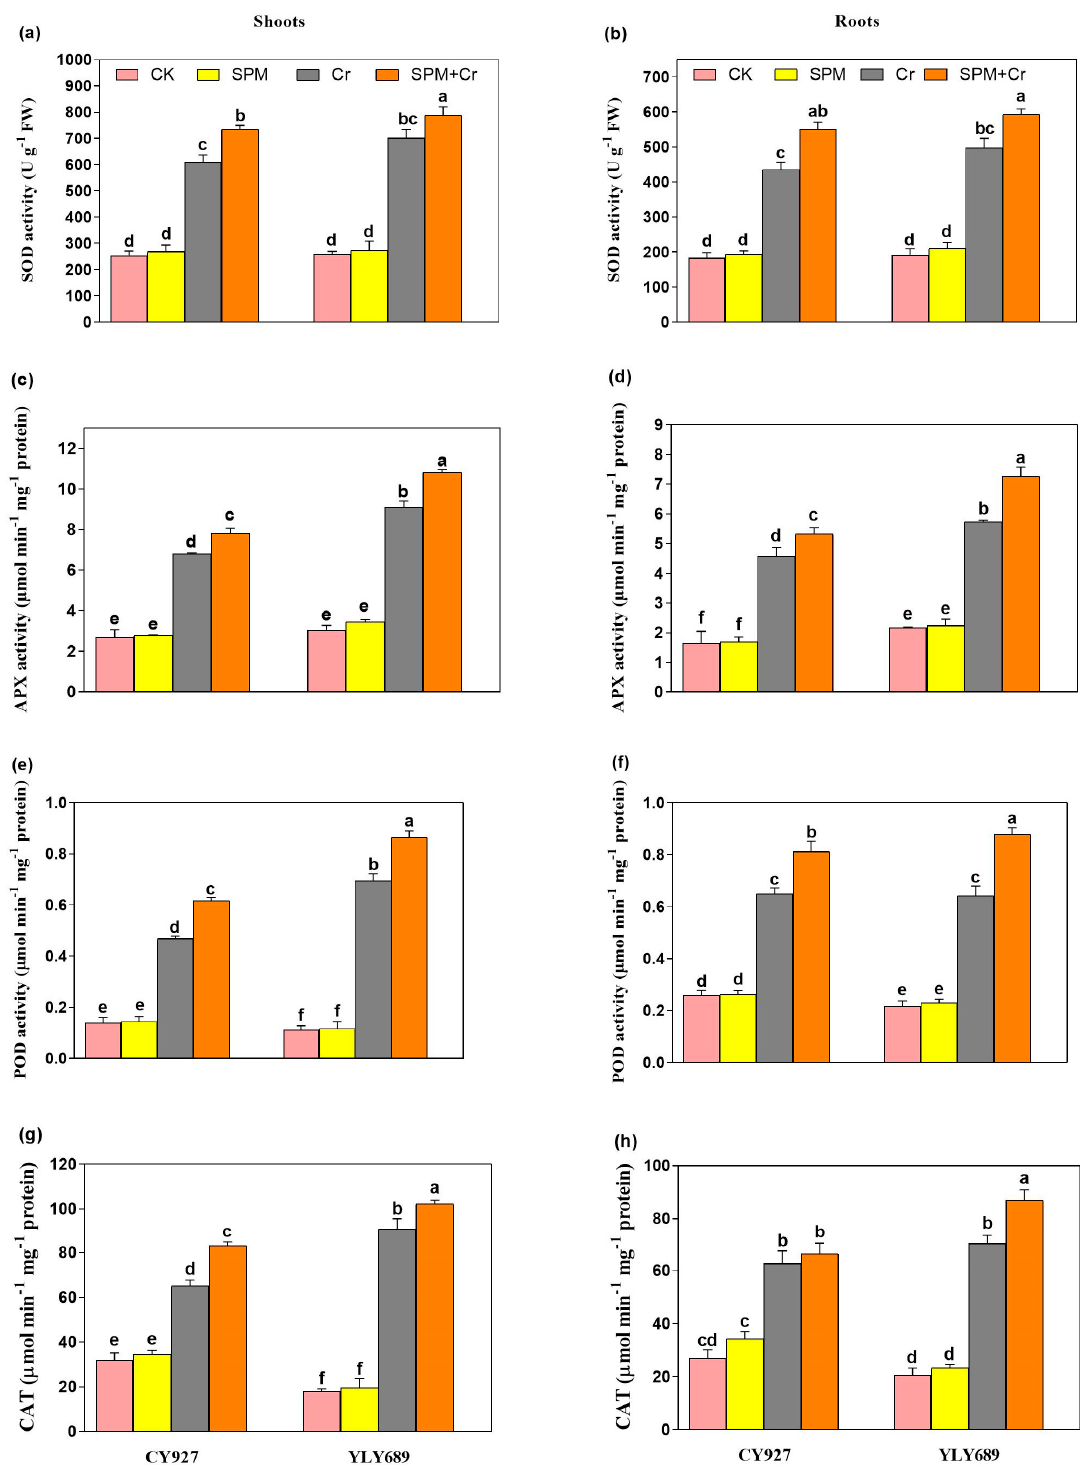
Figure 4. Effects of SPM on the activities of ( a ) superoxide dismutase (SOD) in shoots, ( b ) superoxide dismutase (SOD) in roots, ( c ) ascorbate peroxidase (APX) in shoots, ( d ) ascorbate peroxidase (APX) in roots, ( e ) peroxidase (POD) in shoots, ( f ) peroxidase (POD) in roots, ( g ) catalase (CAT) in shoots, and ( h ) catalase (CAT) in roots of both rice varieties (CY927 and YLY689) under chromium (Cr) stress. Values are mean ± SE of three independent replicates and different letters (a–f) above bars show a significant difference between treatments by LSD test at p <